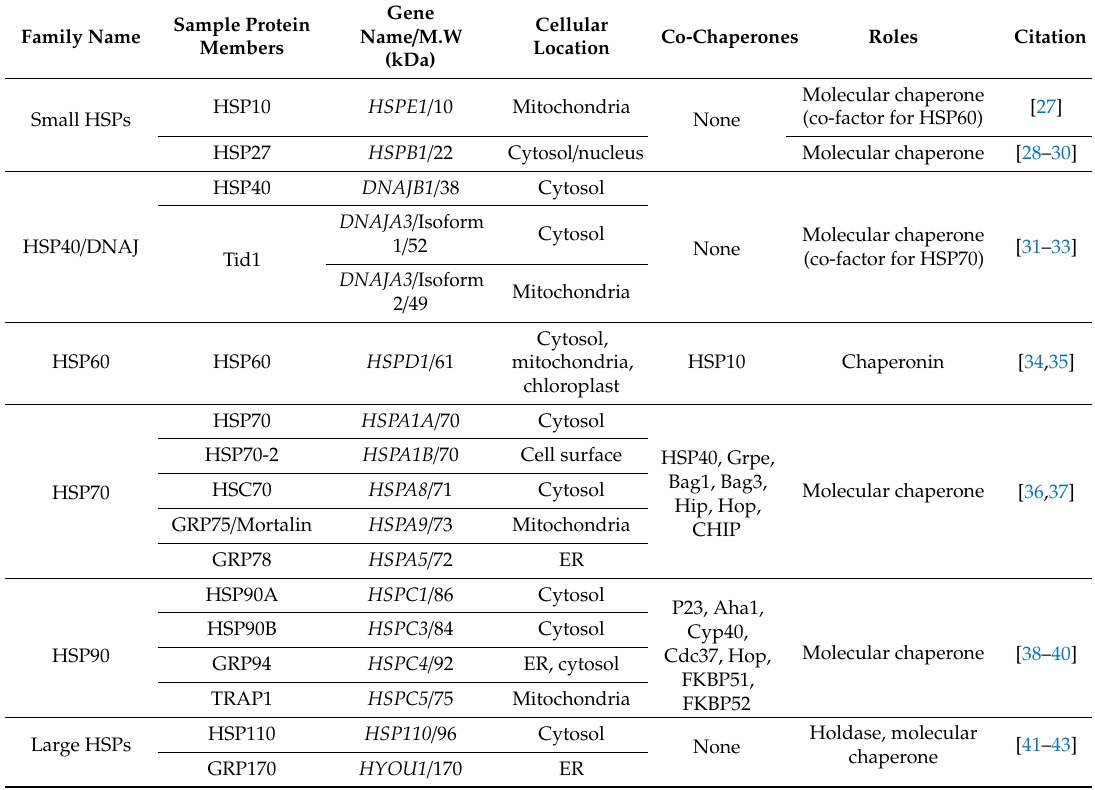
Table 1. Variant families of HSPs and sample members from each